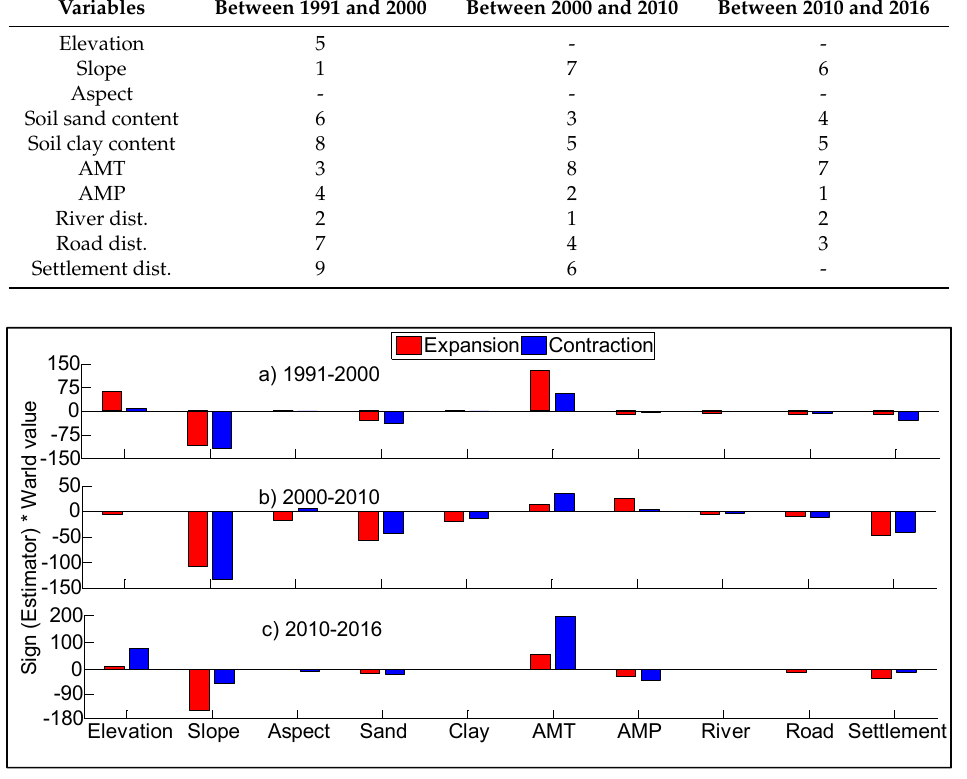
Figure 8. Comparative analysis of the relative importance of different factors driving the farmland expansions and contractions within Chinese TRB region. ISPRS Int. J. Geo-Inf. 2018 , 7 , x FOR PEER REVIEW